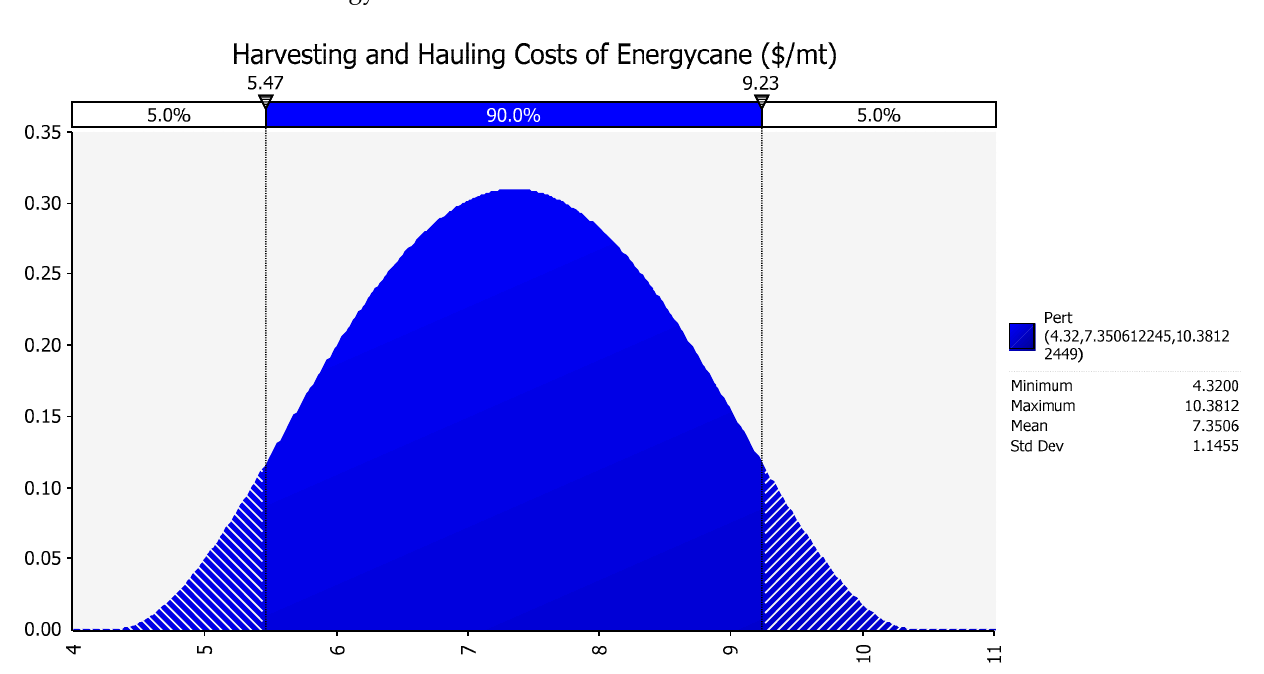
Figure 3. Summary of costs to operate a harvesting and hauling unit/mt of energycane.